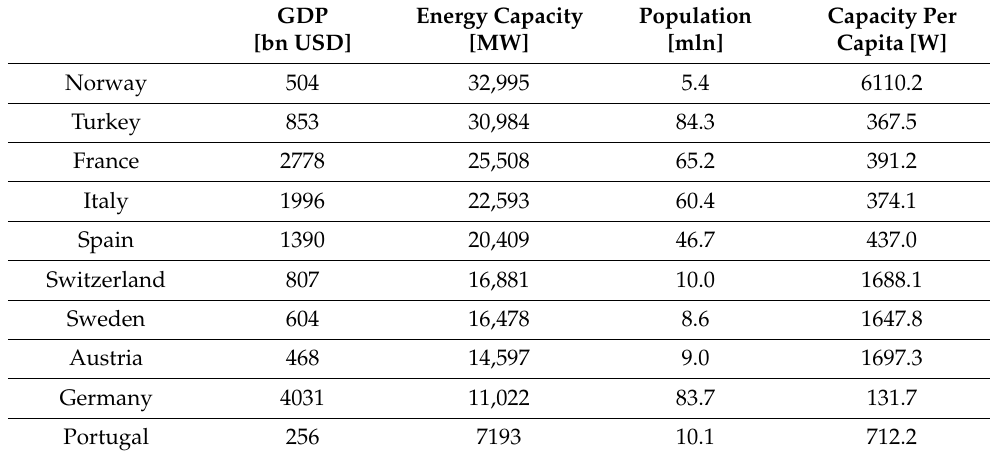
Table 4. Ten European countries with the highest installed hydropower capacity (MW).